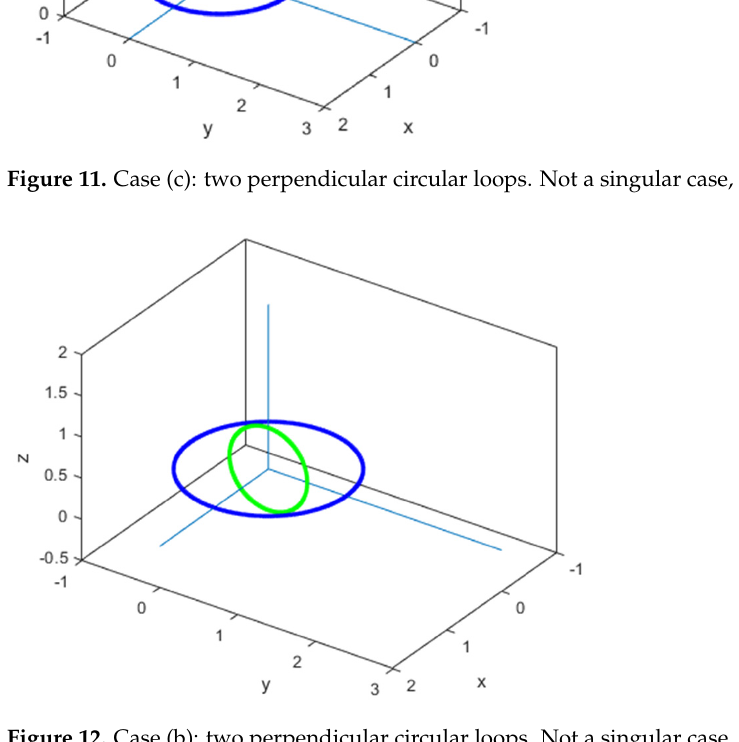
Figure 12. Case (b): two perpendicular circular loops. Not a singular case, ( a = 1, b = c = 0, L = l = 1). (a) C (0 m ,2 m ,3 m ) By the presented method,